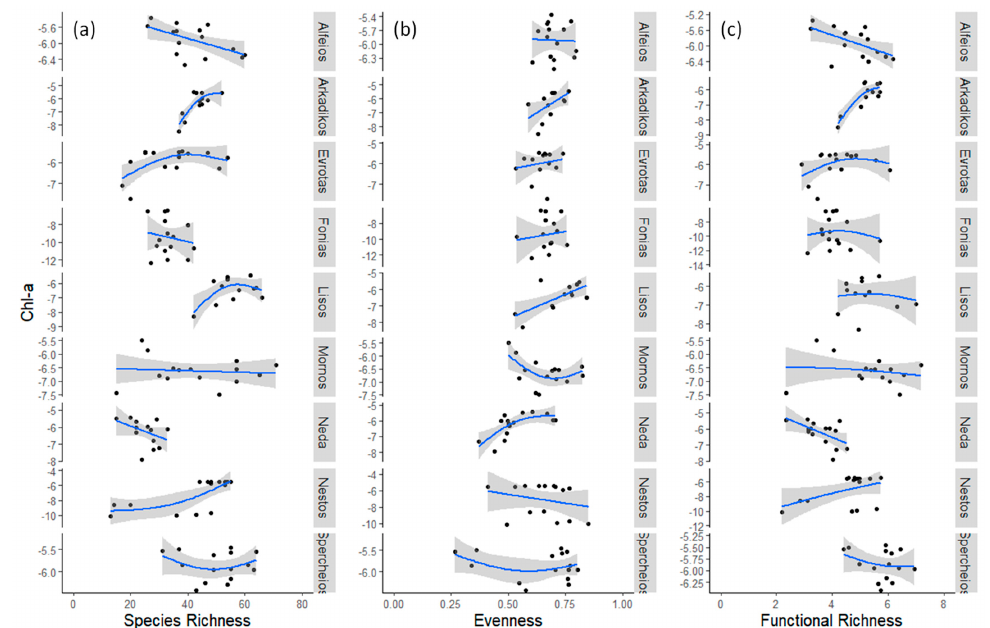
Figure A4. Diversity (expressed as ( a ) species richness-S, ( b ) evenness-J, ( c ) functional richness-FRichness in x-axis) and biomass (ln Chl-a in y-axis) relationship for each river. Biology 2023 , 12 , x 15 of 18